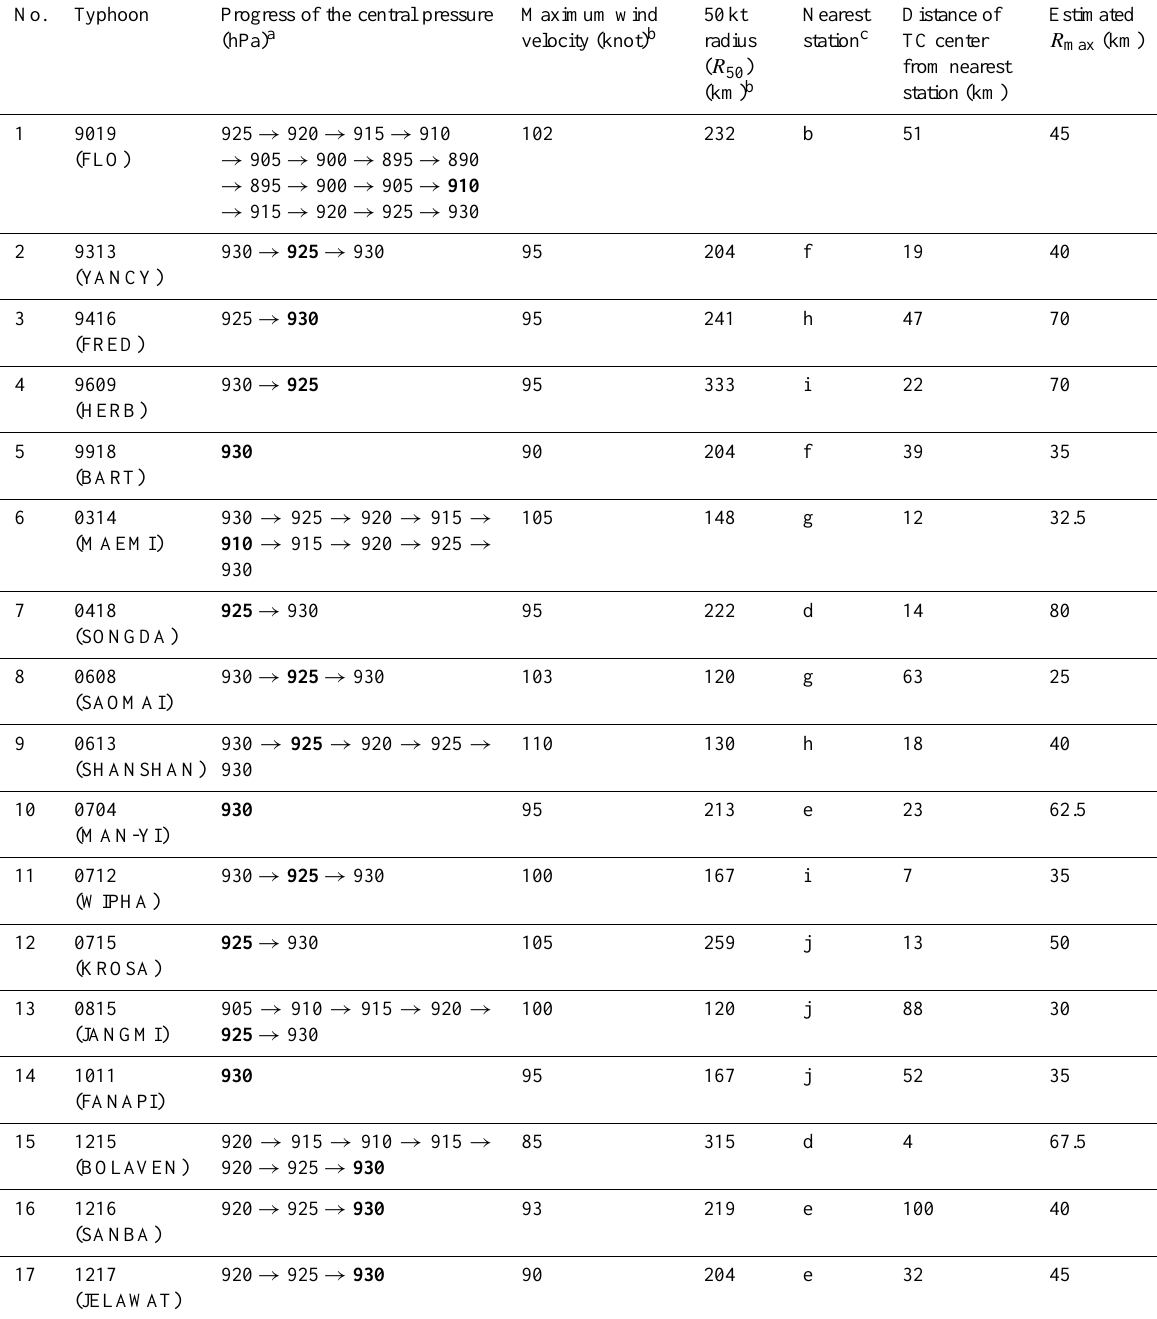
Table 2. Characteristics of the 17 typhoons selected for this study. No. Typhoon Progress of the central pressure